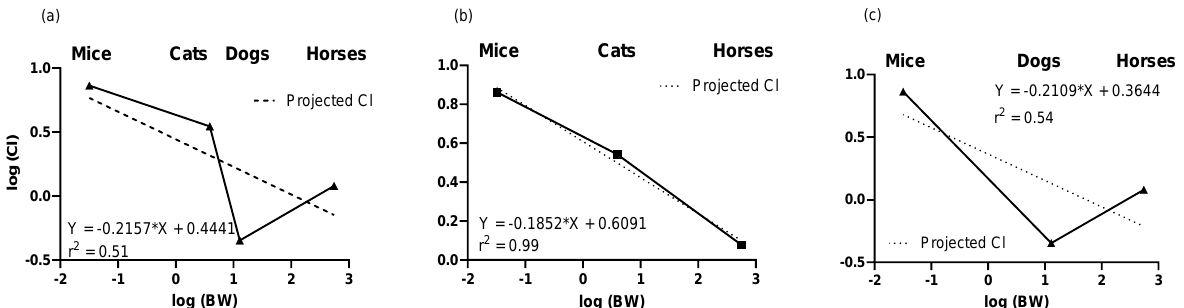
Figure 3. Relationship between clearance vs. body weight. The accuracy of observed clearance was compared to the pre- dicted clearance based on body weight. Clearance was predicted based on the graphing observed clearance values vs. body weight for mice, cats, dogs and horses ( a ), excluding dogs ( b ) or excluding cats ( c ). Excluding dog clearance improved tested 6-days after MSU injection (data not shown). the accuracy of allometric scaling.